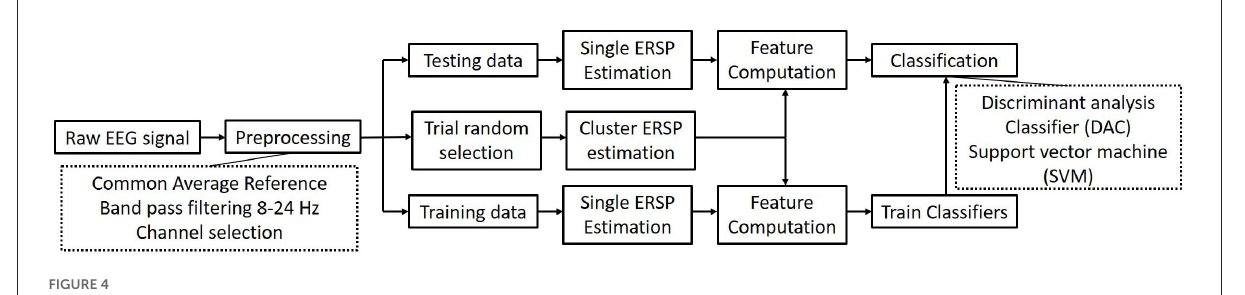
FIGURE4 The architecture of the binary right hand motor imagery